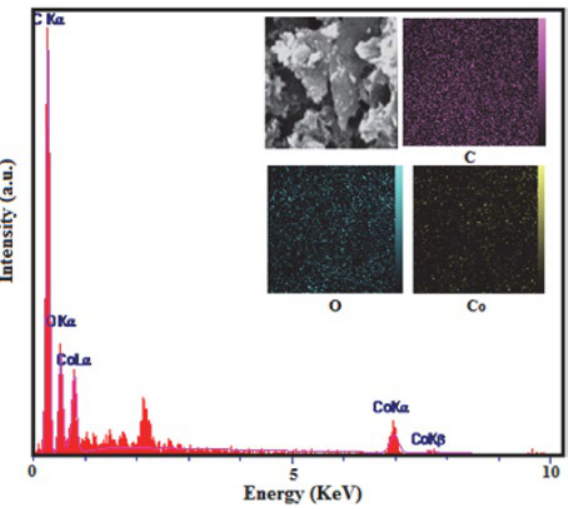
Figure 6. EDX spectrum of GO/Co shows the corresponding EDX elemental mappings.